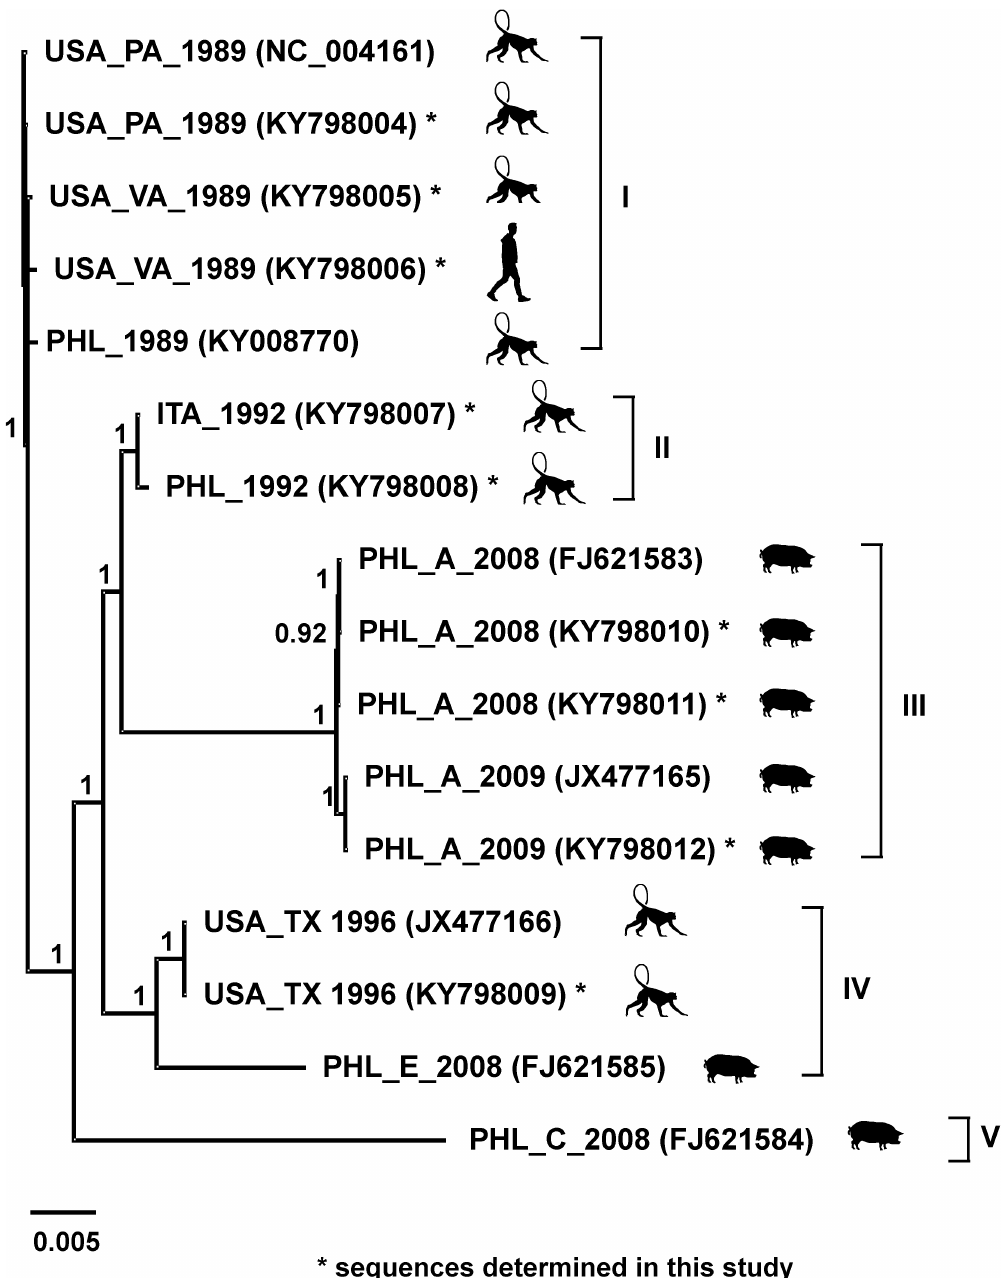
Fig 2. Phylogenetic analysis of available full-length RESTV genomes. Phylogeneticanalysiswas donewith a Bayesianalgorithmusing Geneious6.1.5. CladesI to V are indicatedwith brackets, Asterisks indicatethe 9 sequencesdetermined in this study. Posterior probabilities are listed next to each nodes. Scale bar indicates nucleotide substitutionsper site.